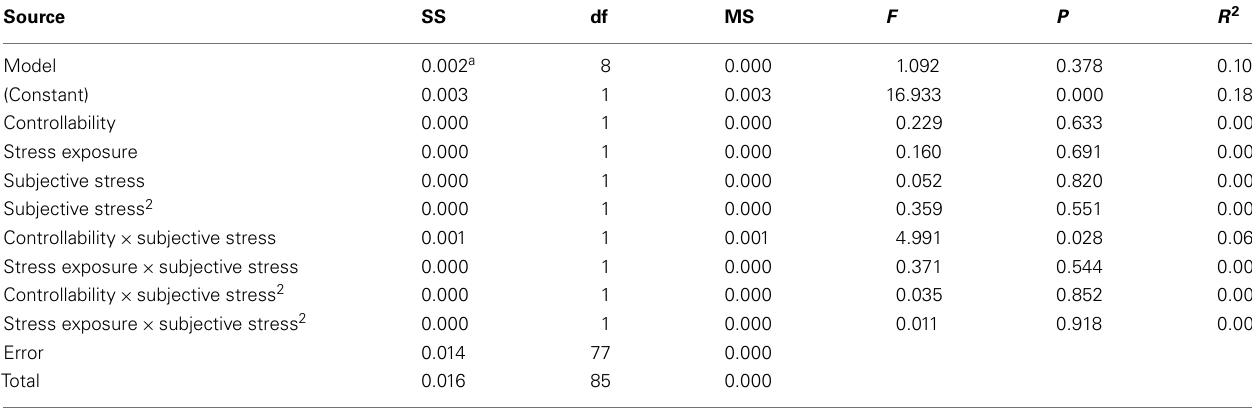
Table 5 | Regression table for Experiment 2, model predicting change in Stroop interference (post-pre stress manipulation) by group status (controllability: compares CSt versus USt groups; stress exposure: compares NSt group versus the average across CSt and USt groups); subjective stress response (subjective stress: the linear effect of subjective stress; subjective stress 2 : the quadratic effect of subjective stress); and interactions between these